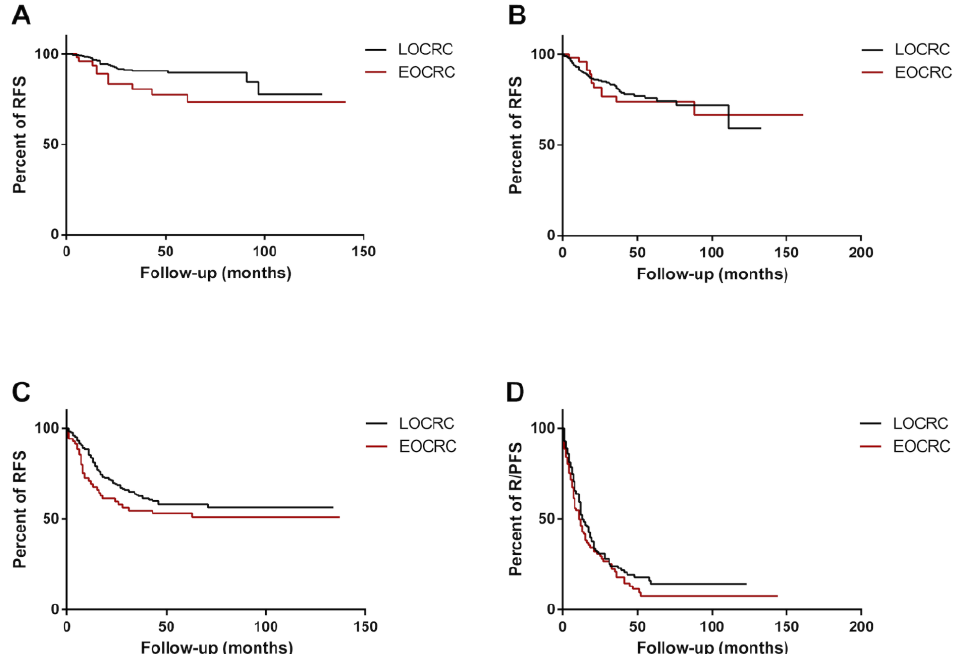
Figure 2. R/PFS (recurrence/progression-free survival) of EOCRC (early-onset colorectal cancer) and LOCRC (late onset colorectal cancer) patients according to the postoperative tumoral stage: ( A ) RFS of EOCRC (red line) and LOCRC (black line) patients diagnosed with tumoral stage I were compared with Kaplan–Meier analysis and log-rank (Mantel–Cox) test (HR = 2.68; 95% CI: 1.07–6.72; p = 0.035). ( B ) RFS of EOCRC (red line) and LOCRC (black line) patients diagnosed with tumoral stage II were compared with Kaplan–Meier analysis and log-rank (Mantel ~ Cox) test (HR = 0.98; 95% CI: 0.53–1.83; p = 0.955). ( C ) RFS of EOCRC (red line) and LOCRC (black line) patients diagnosed with tumoral